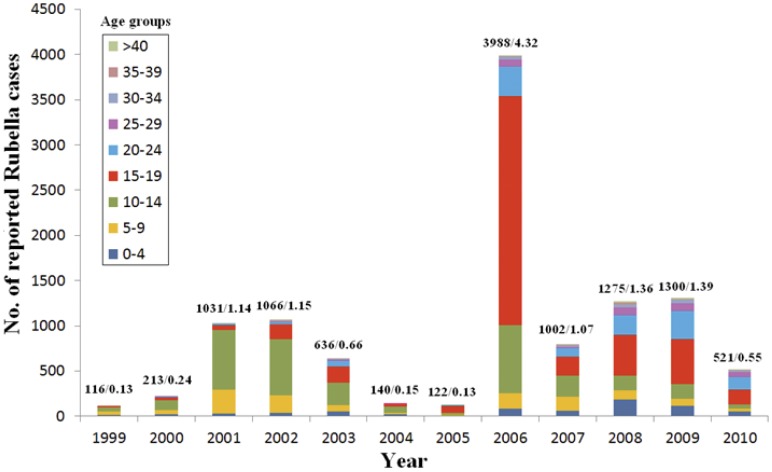
Age distribution of rubella cases in Shandong province, China, 1999–2010.The number above each column represents the number of reported rubella cases and average rubella incidence (per 100,000) in Shandong province, China.